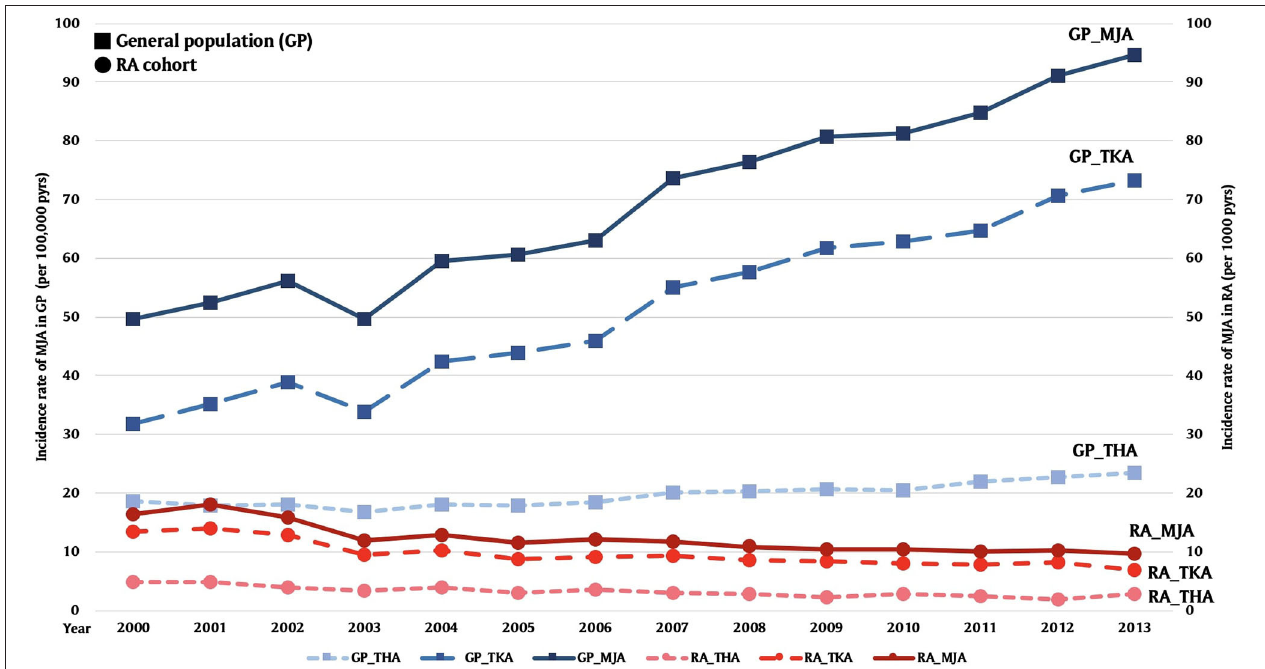
FIGURE 2 | Comparison of incidence rates of total hip arthroplasty (THA), total knee arthroplasty (TKA), and major joint arthroplasty (MJA) between general hospitalization patients (GP) and rheumatoid arthritis (RA) patients from 2000 to 2013 [per 100,000 person years (pyrs) in GP and per 1,000 pyrs in RA patients].